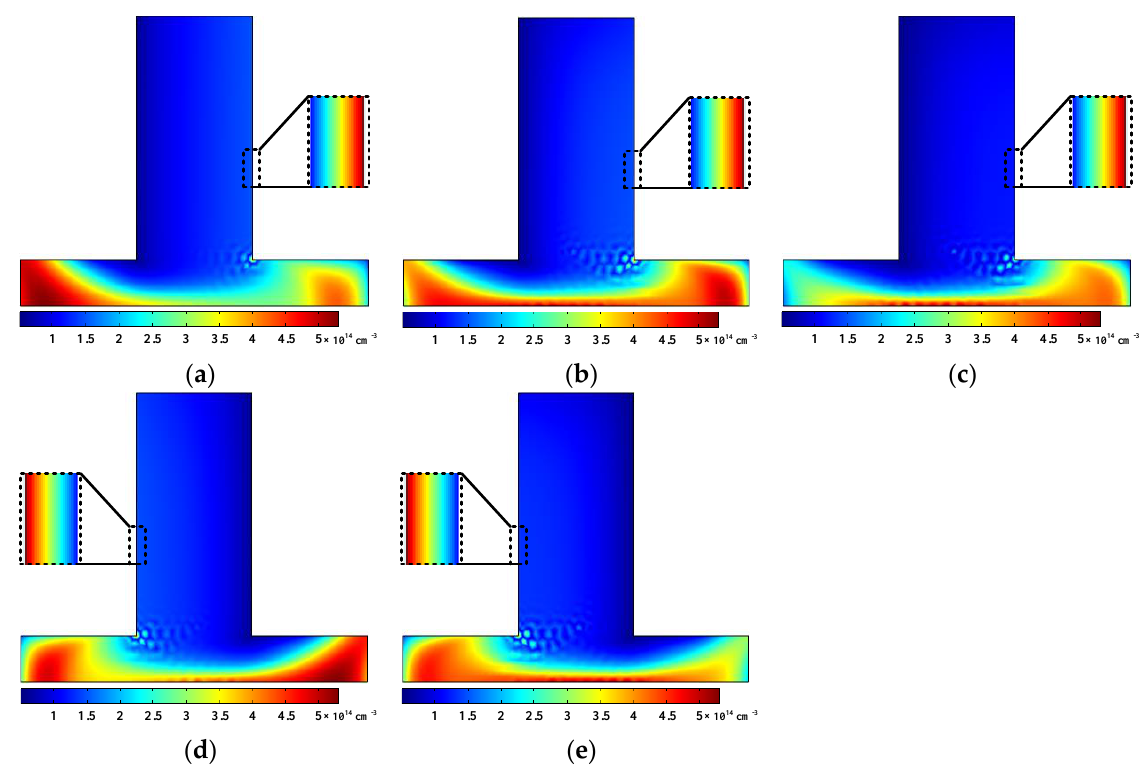
Figure 13. Spatial distribution of the CO 2+ density for times ( a ) 2 ms, ( b ) 6 ms, ( c ) 10 ms, ( d ) 14 ms, and ( e ) 18 ms for the reactor at 22 kV AC voltage and 1 cm distance between electrodes.